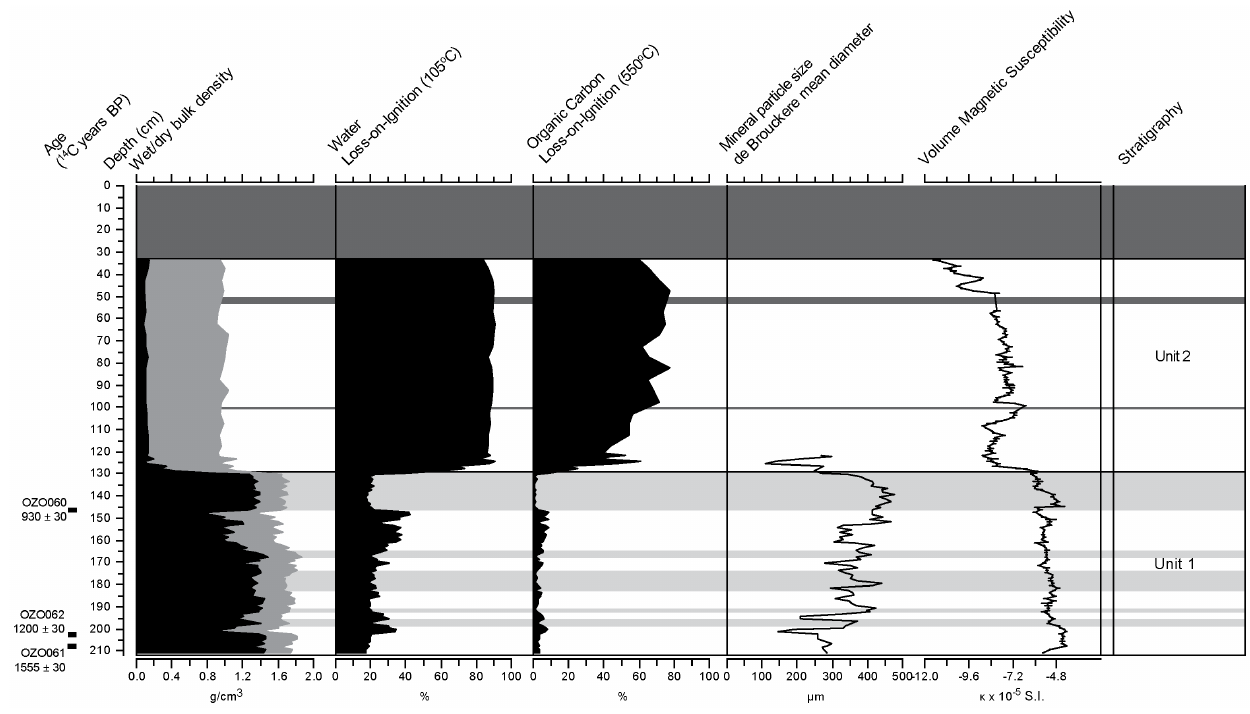
Figure 3. Sedimentology of core TMR/B. Plot of wet (grey)/dry (black) bulk density, loss-on-ignition at 105 u C and 550 u C, DeBroukere mean diameter, volumetric magnetic susceptibility and stratigraphic units for core TMR/B. Light gray shading represents sand beds. Dark gray shading represents no data. See text for descriptions.